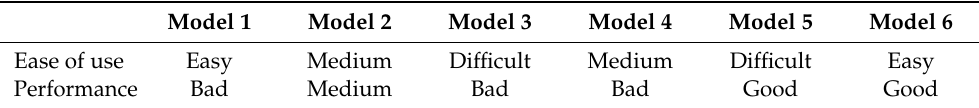
Table 4. Assessed ease of use and performance of the six tested methods to reliably predict TP ModAnnual of new